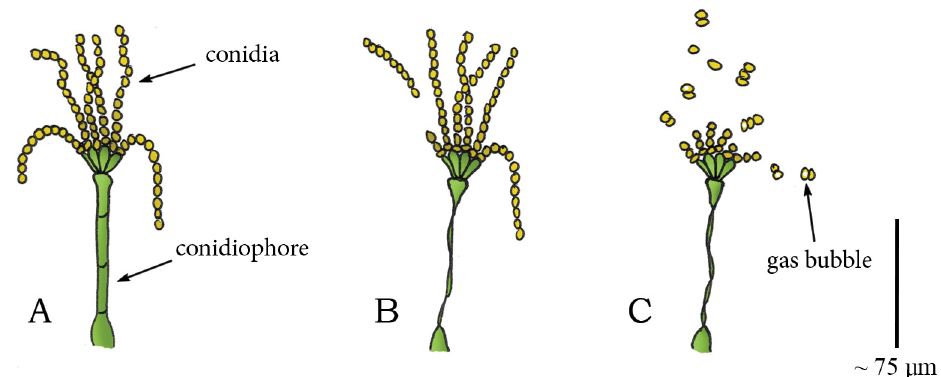
Fig 8. Cavitation catapult mechanism in Memnoniella subsimplex . (A) Conidiophore of M . subsimplex with conidia in a chain-like fashion at its apex. (B) Twisting of the conidiophore during drying discharges loosely connected conidia. (C) In [61] it is suggested that a critical “ negative ” pressure (compared to ambient) causes the sudden appearance of gas bubbles in the conidia that releases the tension in the cell walls of the conidia, resulting in a rapid return motion, and the subsequent discharge of the conidia. Drawings based on schematic drawings in [61]. Scale bar 75 μ